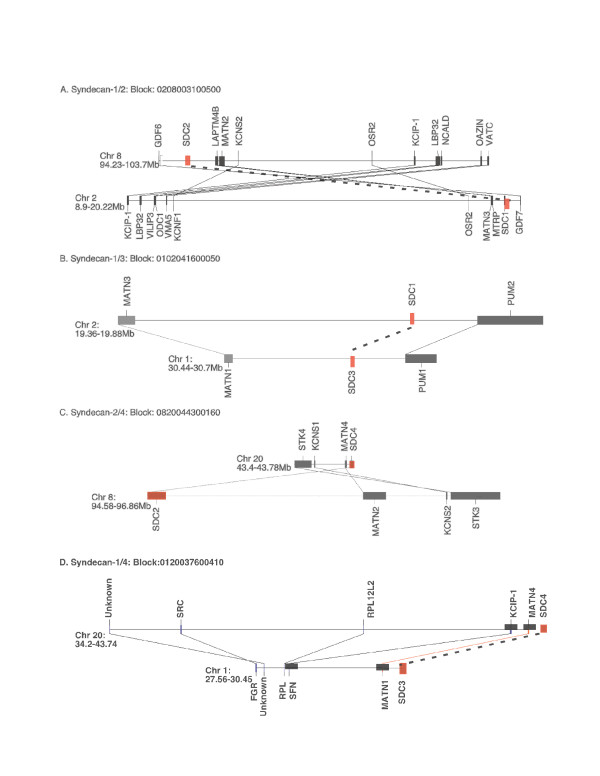
Paralogous locations of syndecan genes within the human genome. Paralogous regions covering all four members of the syndecan gene family were identified in the human genome, from the "dataset of paralogons in the human genome v5.28" 57. Each block number and the exact location of the paralogous regions on the respective chromosomes are also shown. Shaded lines represent how the original blocks were modified to include missing syndecan genes (see methods).